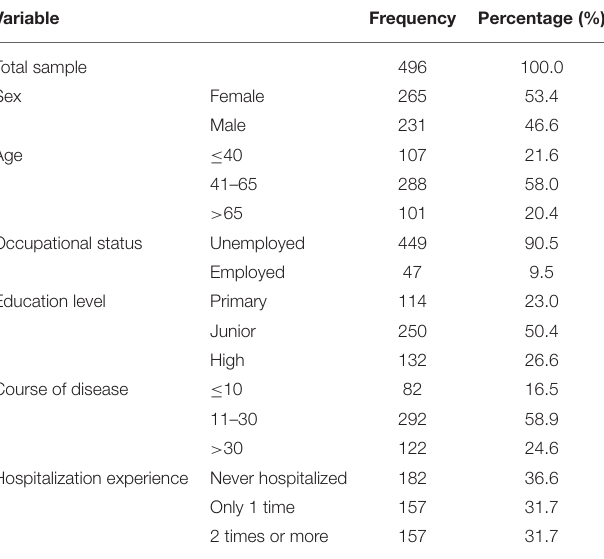
TABLE 1 | Descriptive statistics of basic